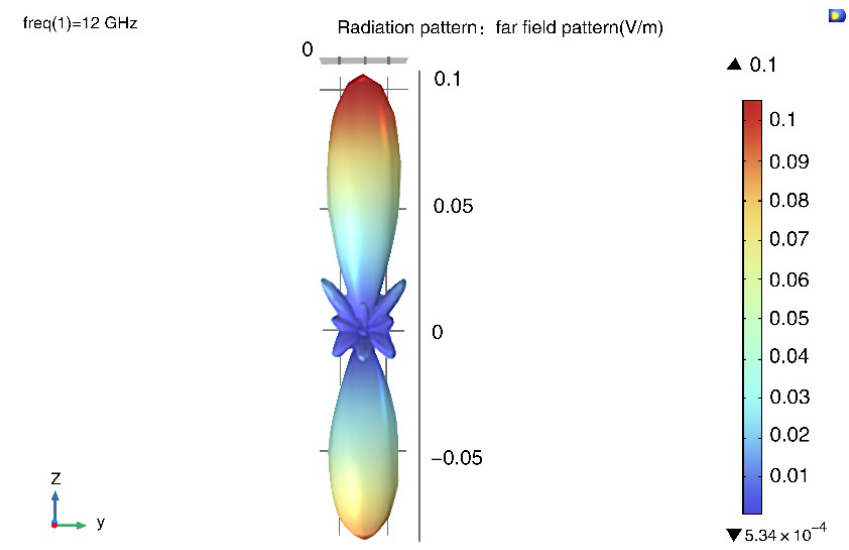
Figure 4. Three-dimensional radiation pattern.